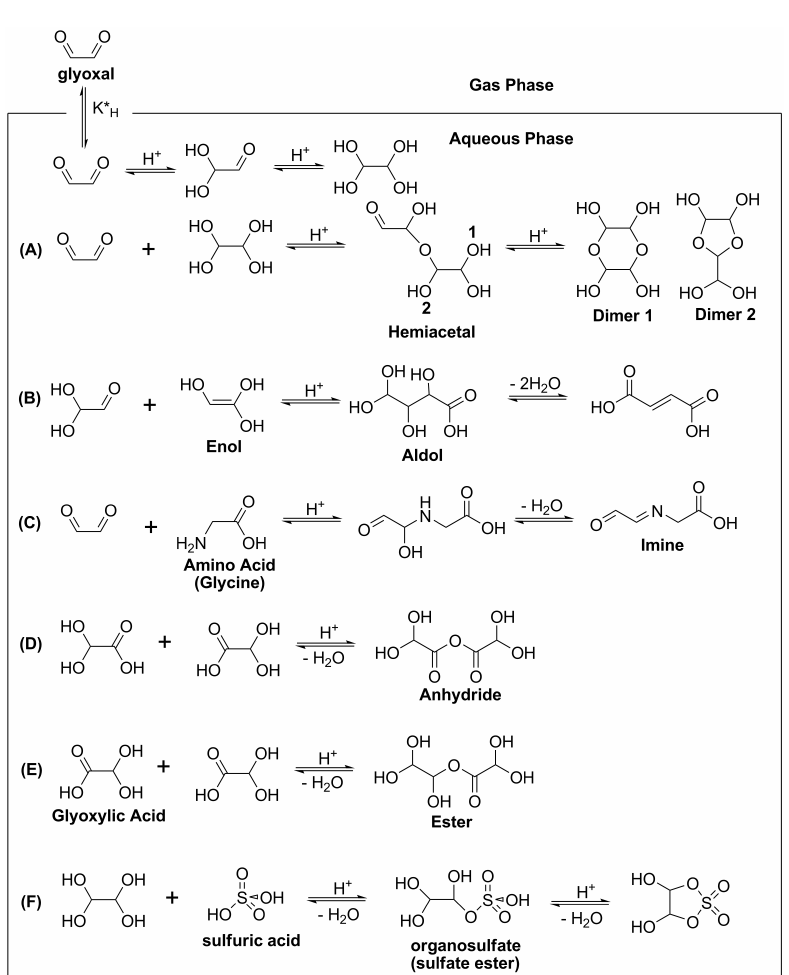
Fig. 1. Glyoxal partitioning (governed by effective Henry’s law, K ∗ H ) , hydration, acid catalysis to form hemiacetal (A) , aldol (B) , imine (C) , anhydride (D) , ester (E) and organosulfate (F) . For (A), glyoxal and hydrated glyoxal form Dimer 1 and 2 depending on which OH group (1 or 2) attacks a carbon in the carbonyl